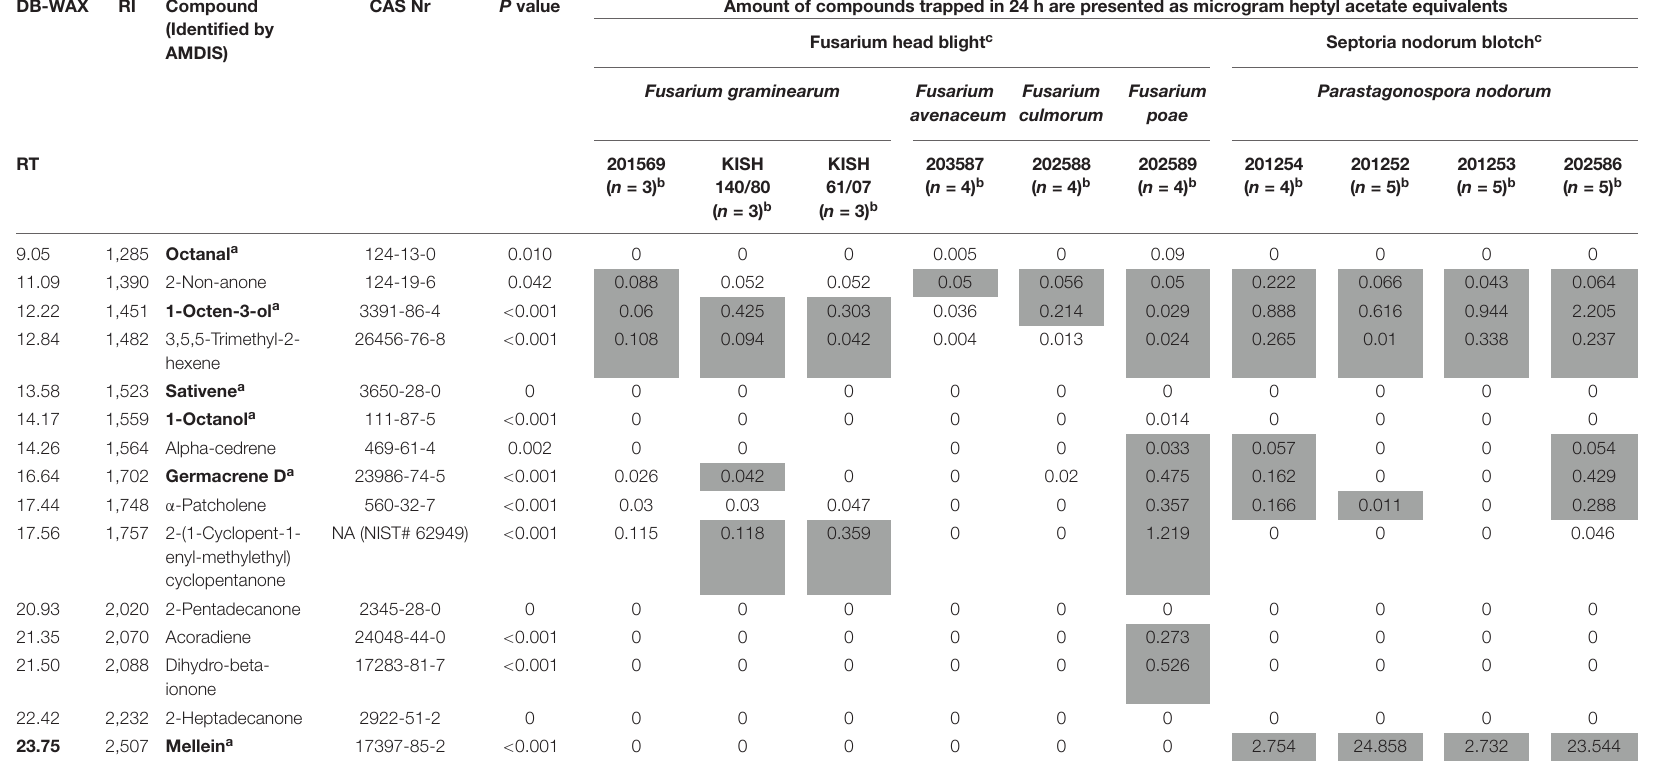
TABLE 2 | Volatile organic compounds in headspace collections from fungal isolates on potato dextrose agar (PDA).